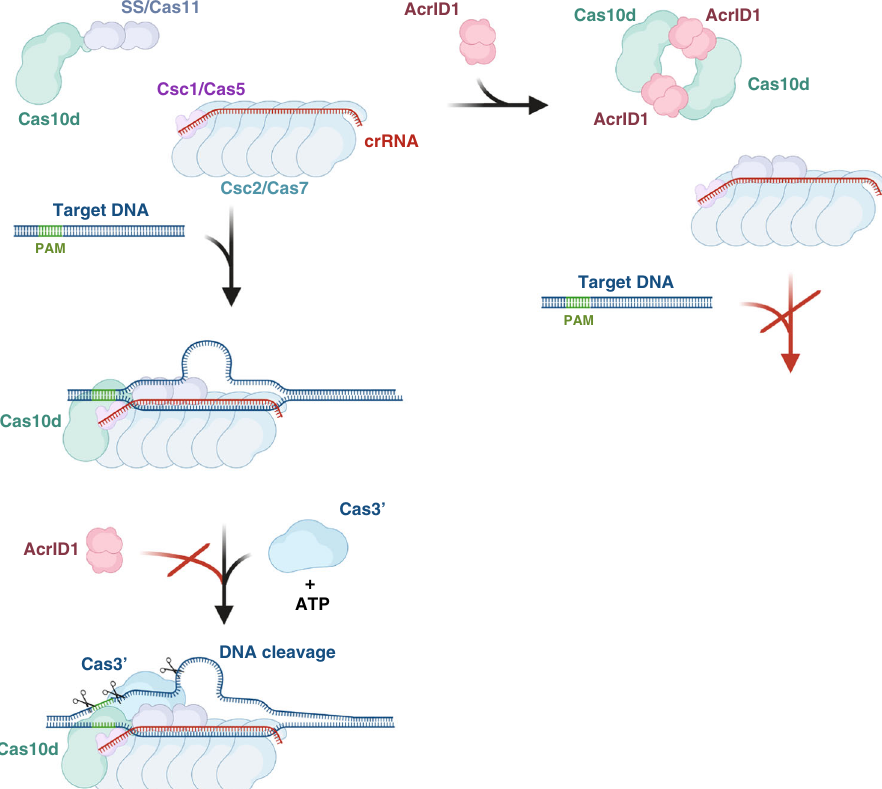
Fig. 6 Model for inhibition of type I-D CRISPR – Cas systems by AcrID1. Left, the backbone complex (consisting of Csc1/Cas5, Csc2/Cas7, and crRNA) can bind Cas10d/SS and target DNA, allowing for multiple cleavage events in the presence of Cas3 ’ and ATP (lower left). The sequential binding order of Cas10d/SS, backbone, and Cas3 ’ to target DNA is not known. AcrID1 interferes with Cas10d prior to DNA binding (top right), sequestering it in a non- functional, higher-order state and preventing interference. Once the backbone:Cas10d:DNA complex is formed, AcrID1 cannot interfere. Figure created with